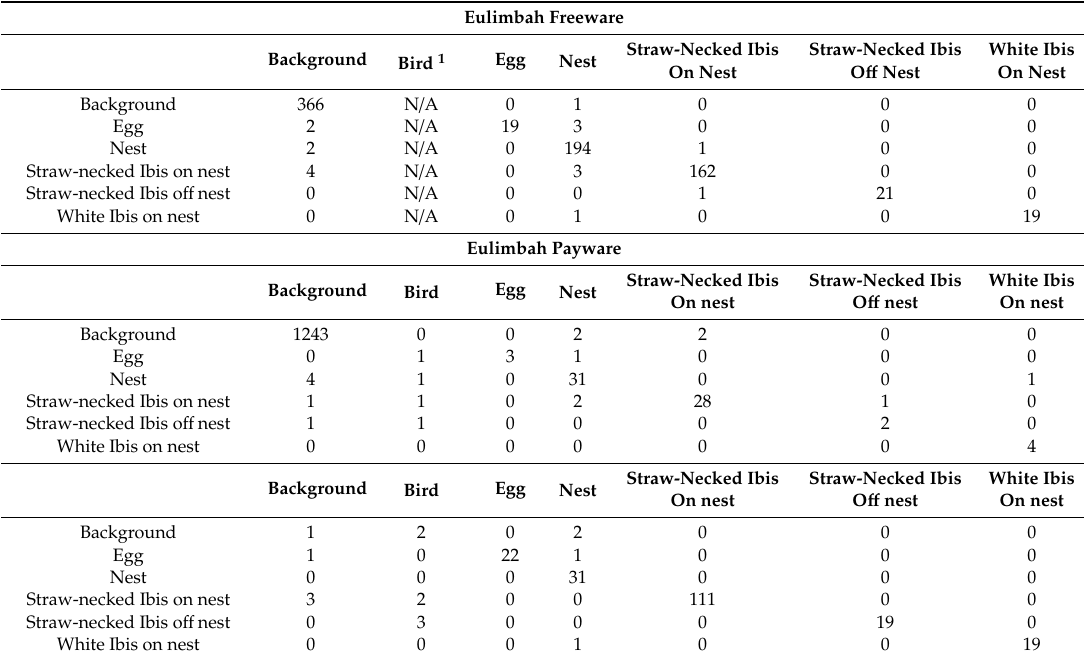
Table 5. Results for the freeware and payware used in development of semi-automated methods for the Eulimbah colony, showing the secondary error matrix after correcting for probabilities (not necessary at Eulimbah using the freeware method), and the final error matrix after correcting for area, where rows are the test data and columns are the predicted